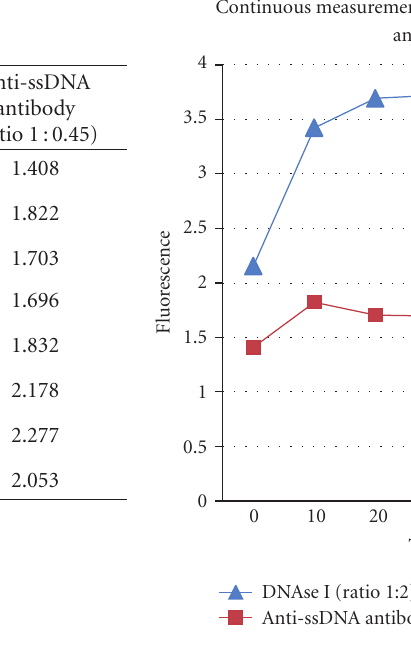
Figure 7: Di ff erences in kinetic behavior of DNAse I and anti-ssDNA lupus antibody in optimized ratios used for detection of ss-DNA hydrolytic activity and expressed in fluorescent units per